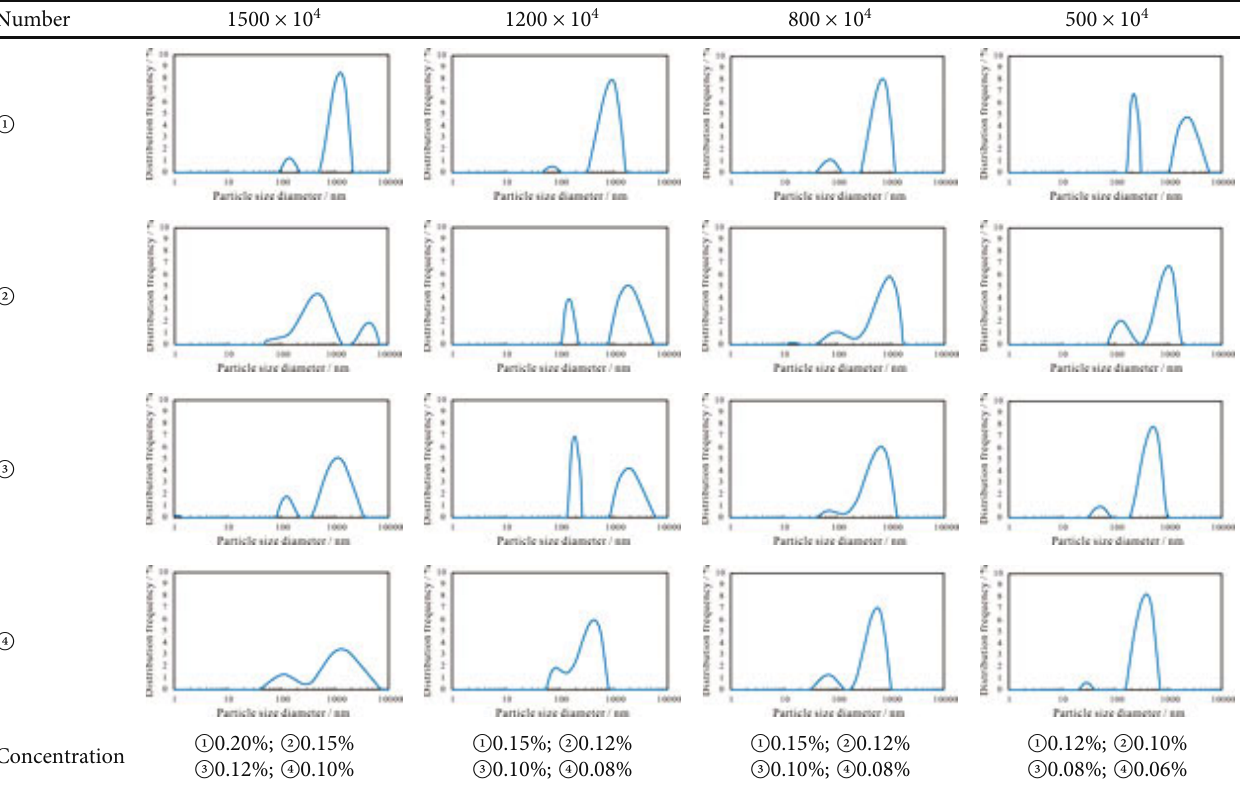
Table 3: Characteristics of the molecular hydrodynamic size distribution of polymer